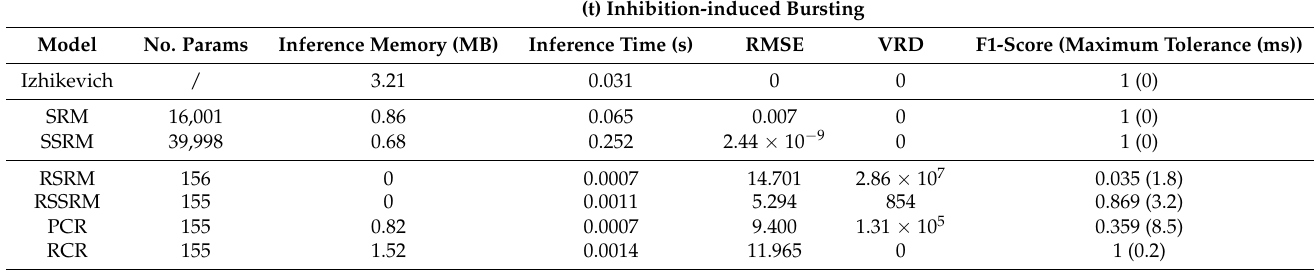
(t) Inhibition-induced Bursting